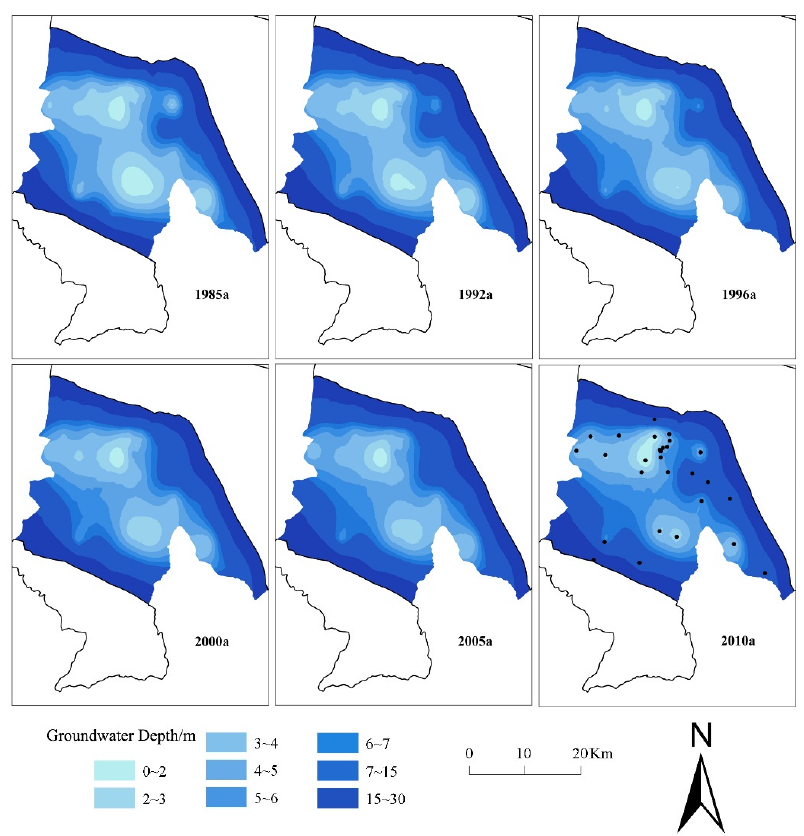
Figure 3. Isogram maps of groundwater depth in Linze County (black dots strand for the monitoring wells). Table 4. The area change of the regions with respect to groundwater depth from 1985 to 2010 (km 2 ).